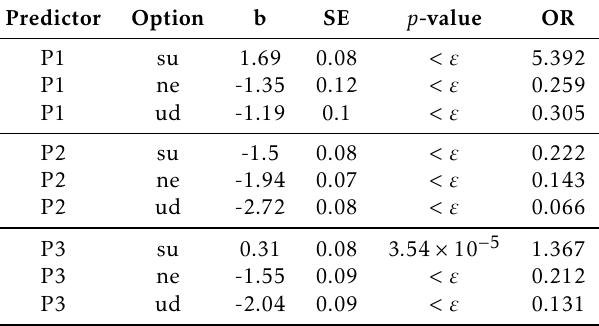
Table 5. Results of a multinomial logistic regression conducted on two password data subsets as the predictor of participants’ self-reported